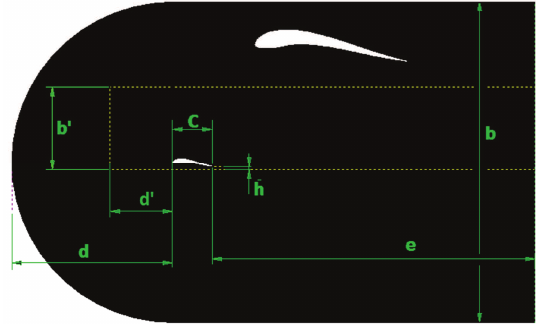
Fig. 3. Model created for simulation of free stream flight, with NACA M8 airfoil geometry